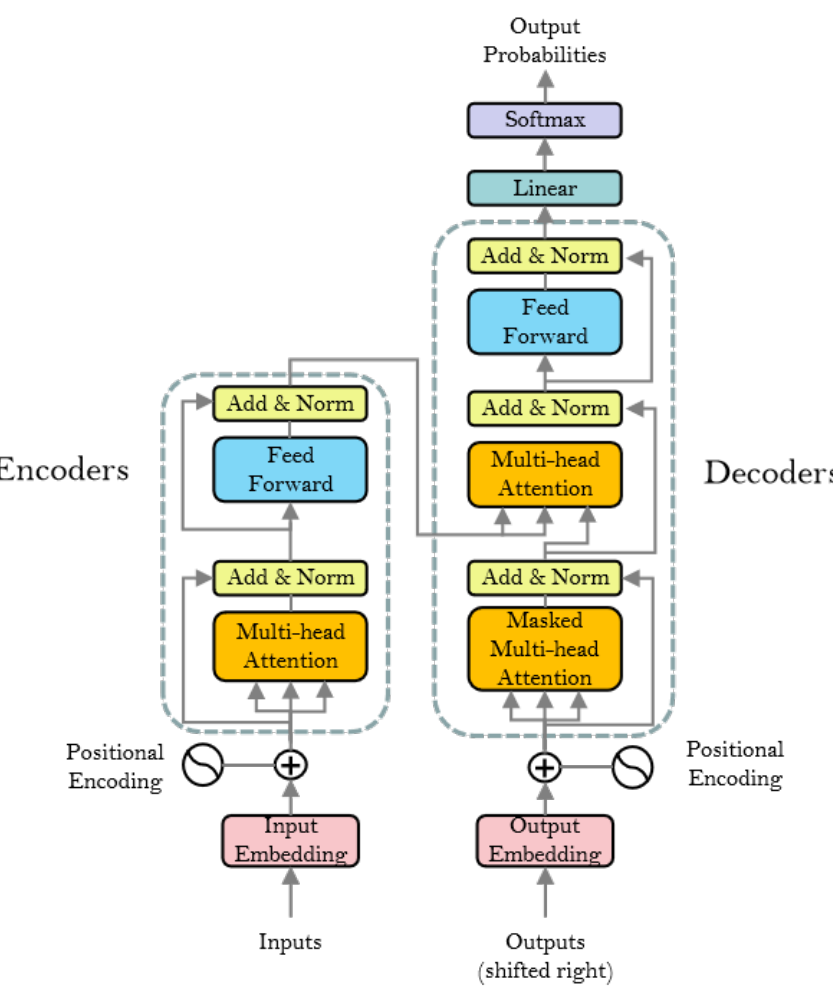
Figure 2. Transformer